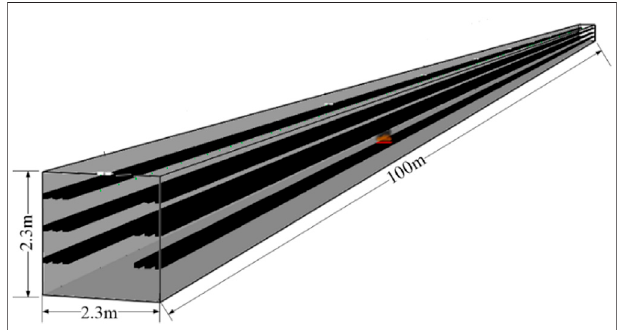
FIGURE 2 | The whole simulation model.